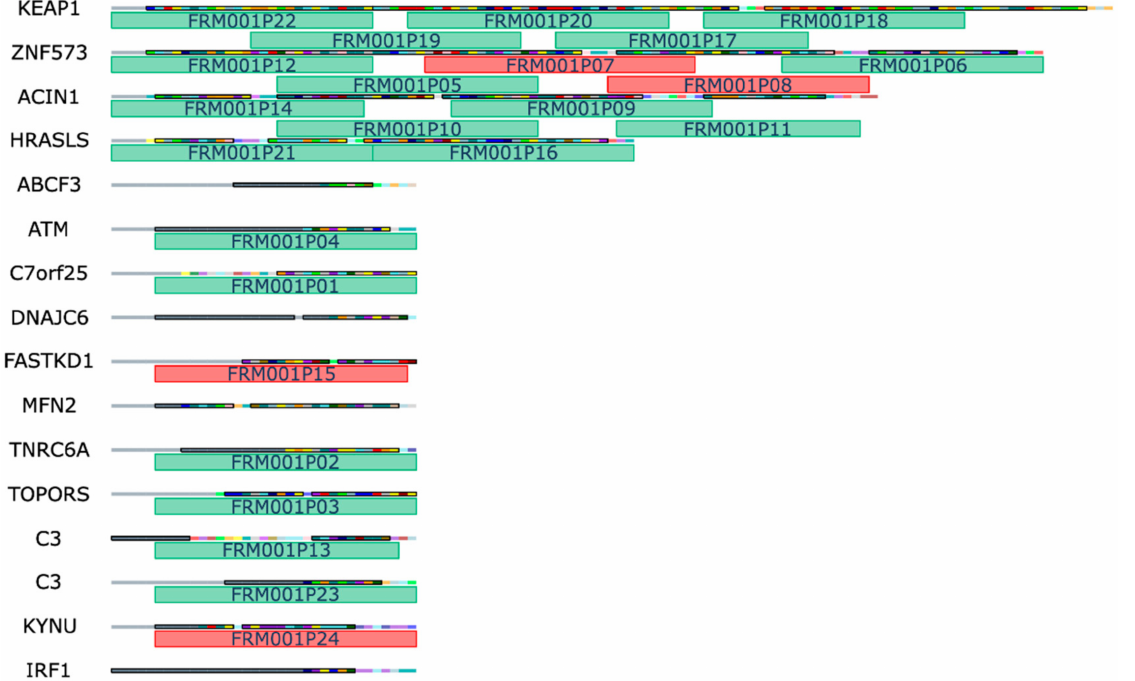
Figure 3. Peptide selection: Framome of lung tumor sample LUN021 where each row represents a NOP where multicolored squares are individual amino acids. Grey regions of the NOP represent appended upstream WT amino acids. Regions of NOP with predicted MHC binding epitopes are highlighted with a black box and enhanced color. The 24 selected peptides with indicated peptide IDs are shown as rectangular regions underneath their parent sequence, with green colored peptides being successfully manufactured while red peptides failed manufacturing (see also Section 3.2). Table 3. The results of the peptide synthesis and freeze-dried peptide mixtures. The synthesized peptides had a sequence of 28–31 amino